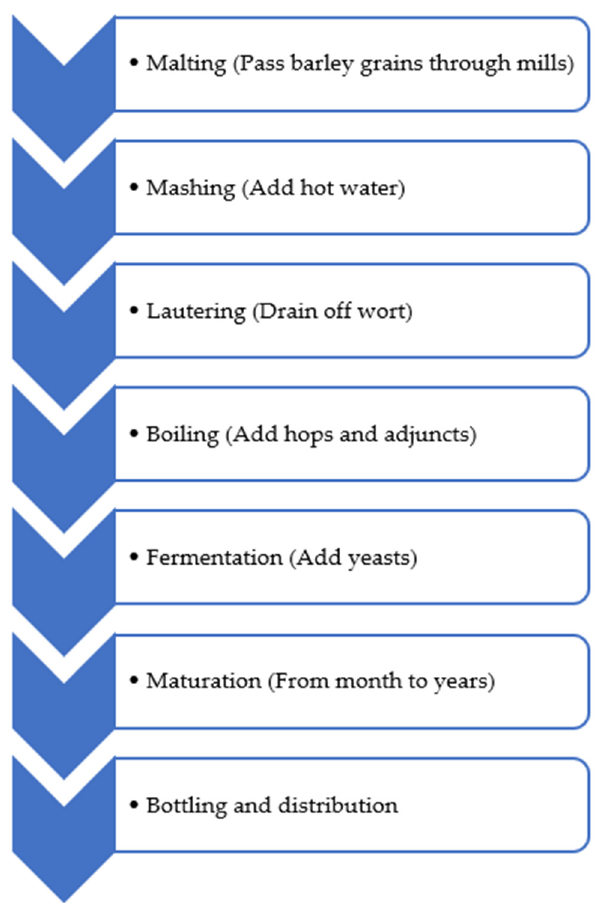
Figure 2. Main steps required for beer production.